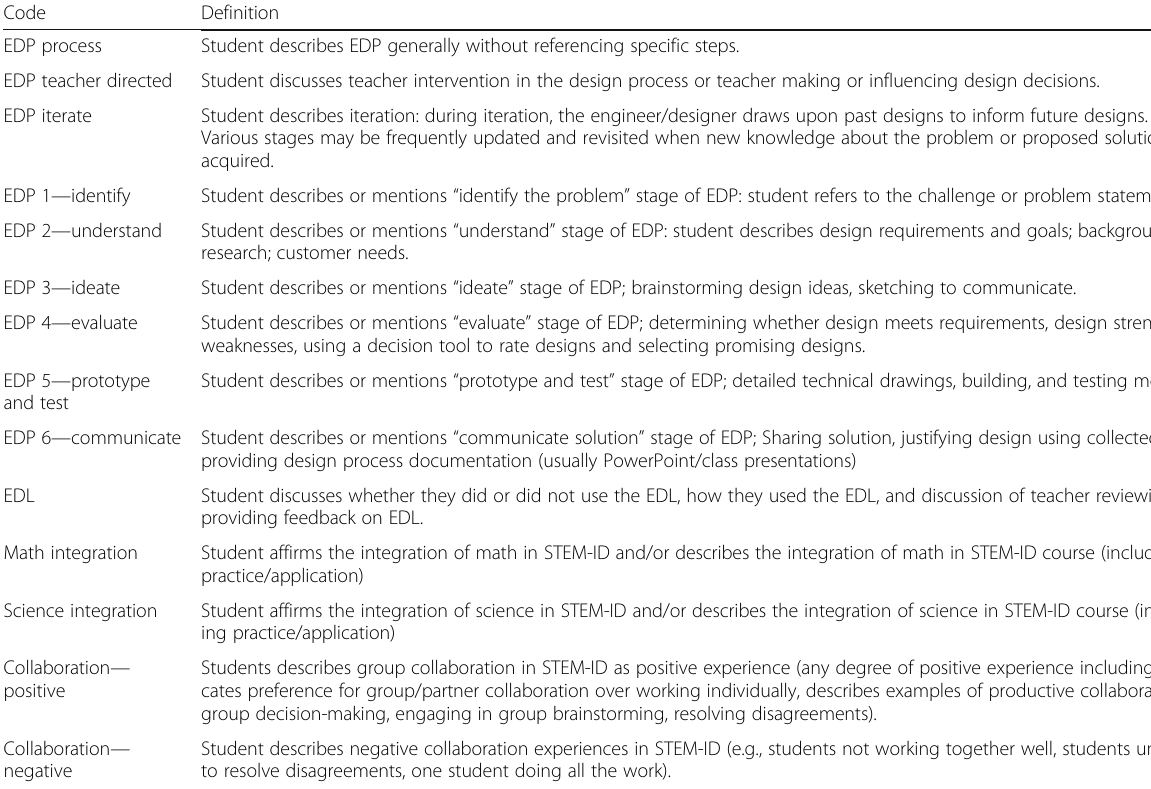
Table 5 Excerpt of coding scheme